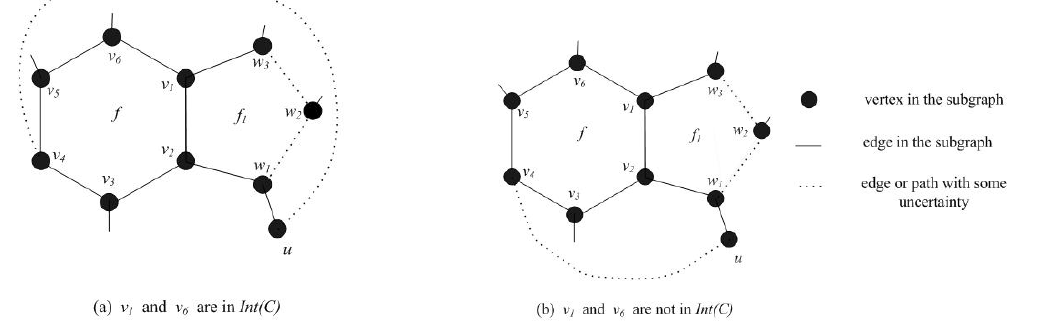
Figure 2. An internal 6-face f is adjacent to an internal 5 − face f 1 that all vertices on f 1 are 3-vertices. v 1 and v 6 are in Int(C) ( a ) and not in Int(C) ( b